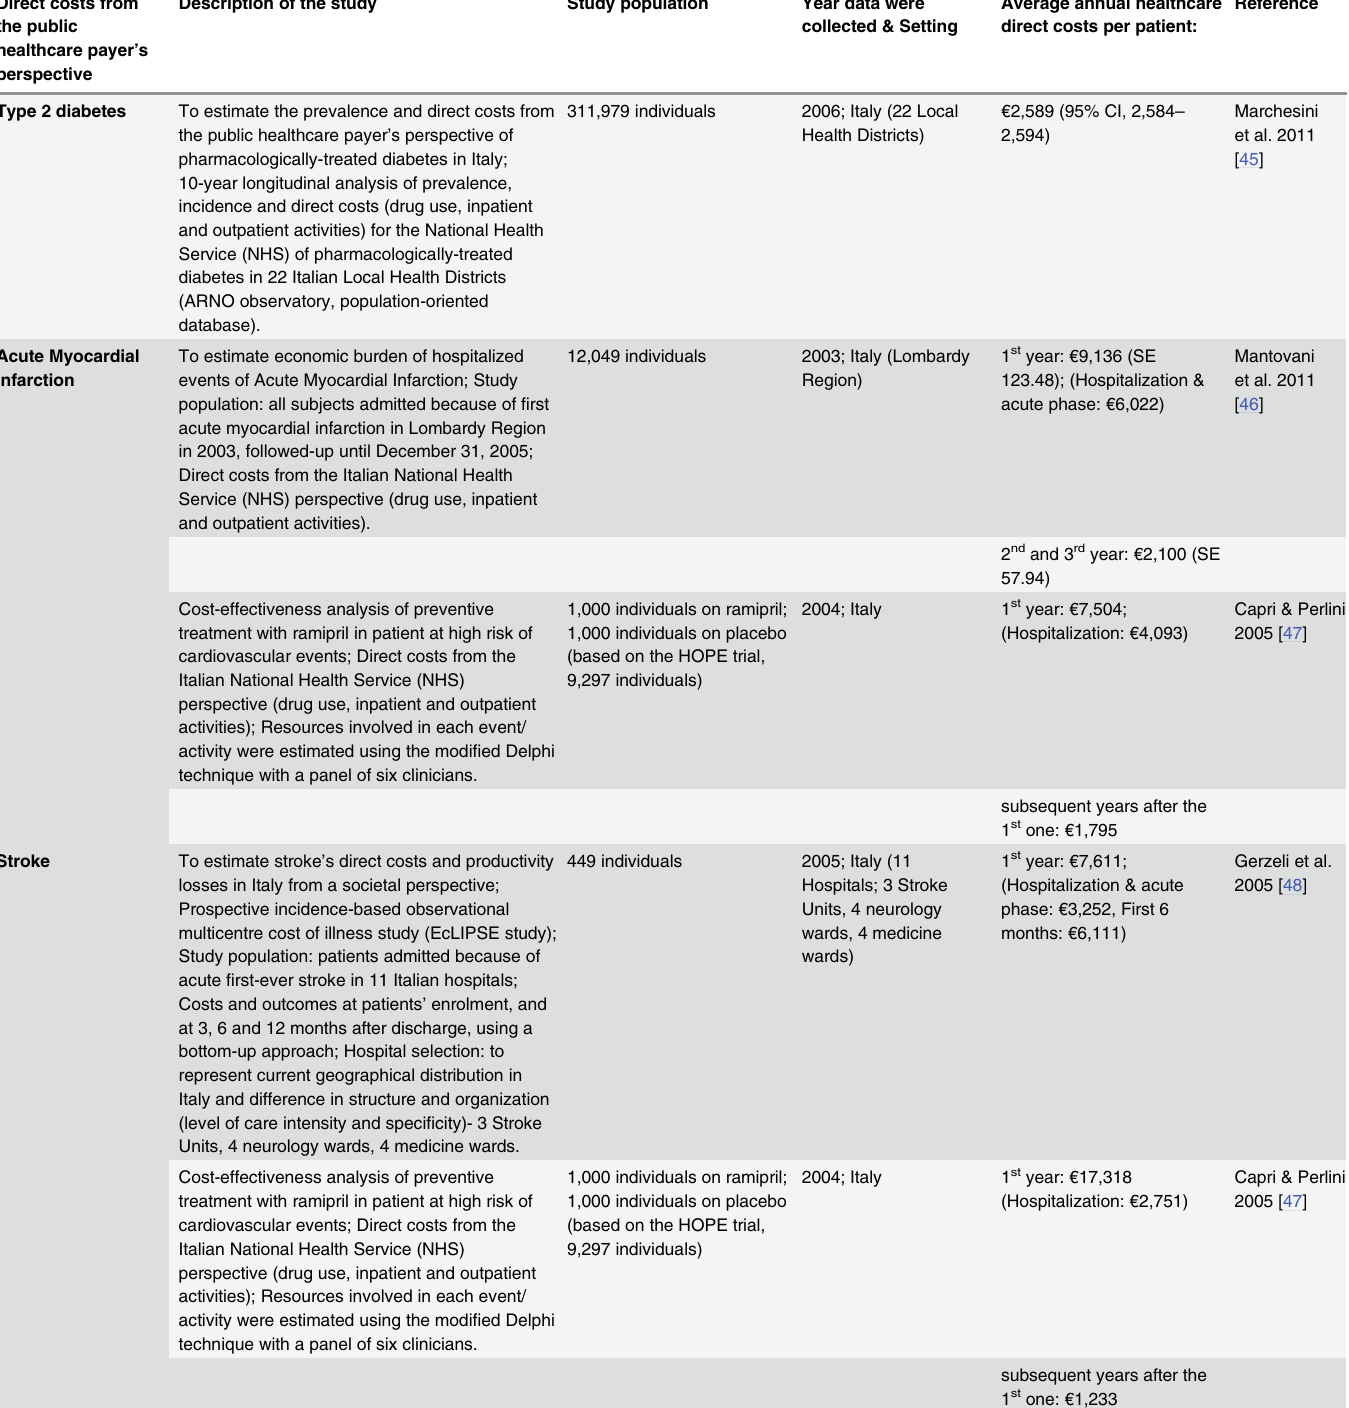
Table 3. Literature data: Direct costs from the public healthcare payer ’ s